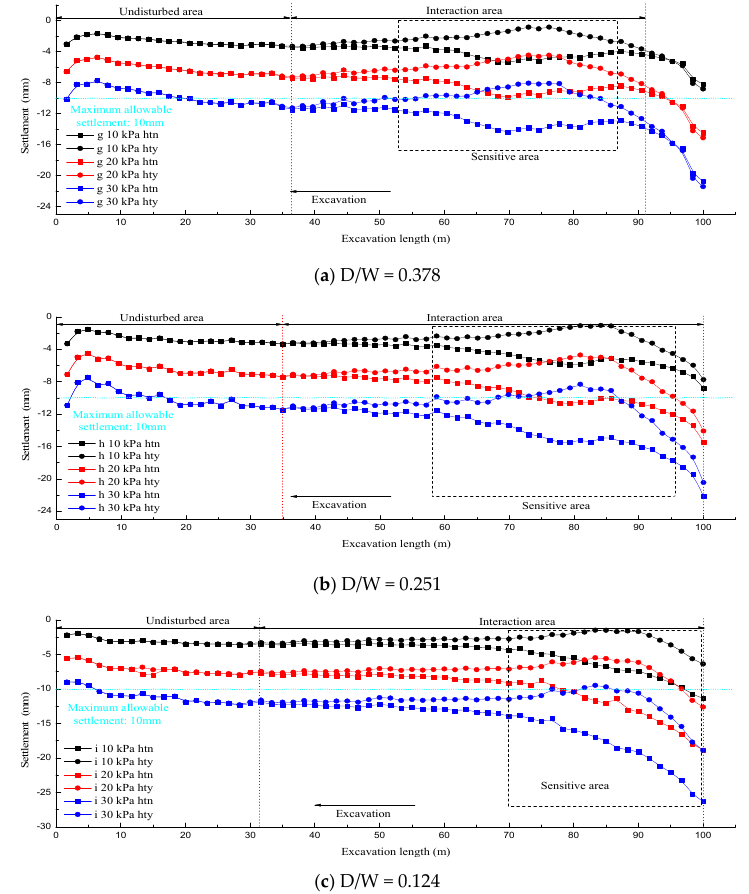
Figure 10. Longitudinal surface settlement of models G-G to I-I with C/H = 0.449.